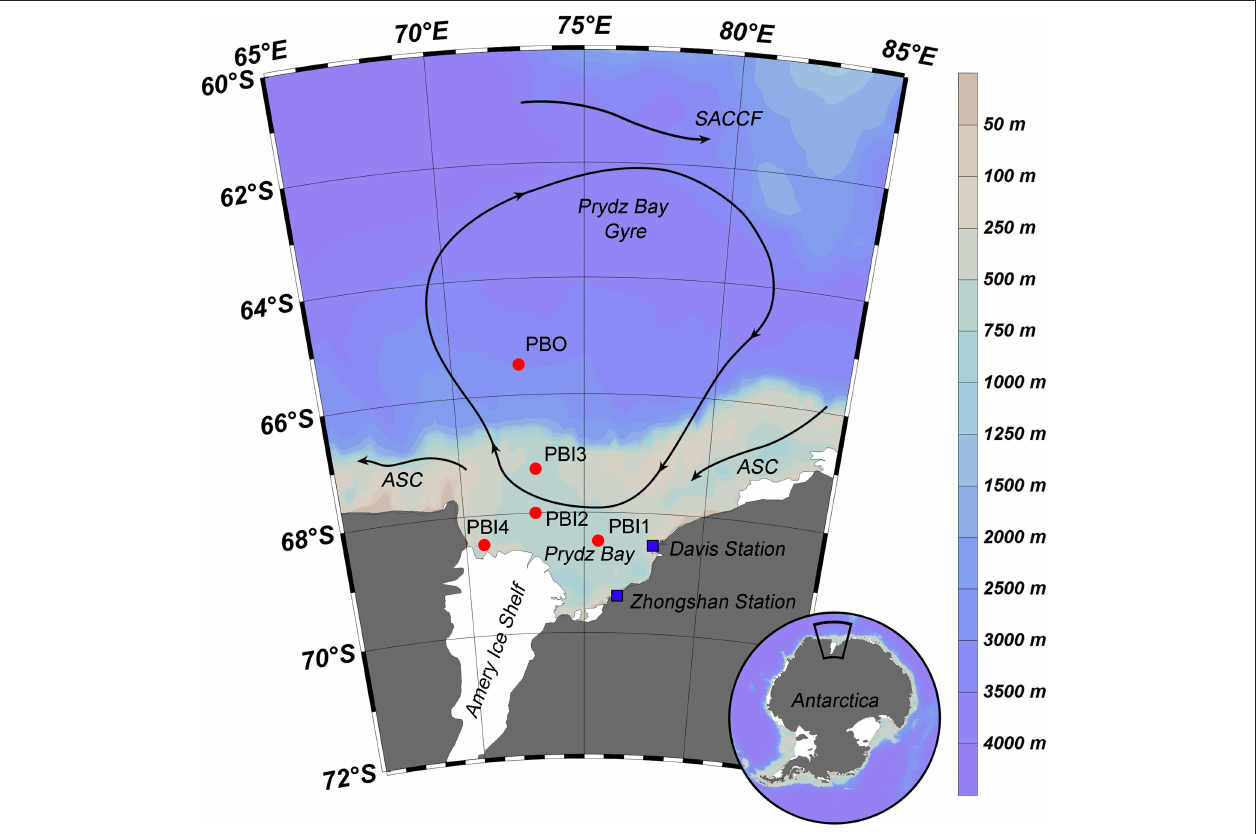
FIGURE 1 | Sampling stations and summer water currents (Revised from Roden et al., 2013) in the Prydz Bay, Antarctic. The direction of the current (arrow and solid line), location of each sampling site (red point), and Antarctic scientific investigation station (blue block) were shown in the map. Different colors represent as deep gray (land), light gray—light blue—deep blue (the depth from shallow sea to deep sea). SACCF, Southern Antarctic Circumpolar Current Front; ASC, the Antarctic slope